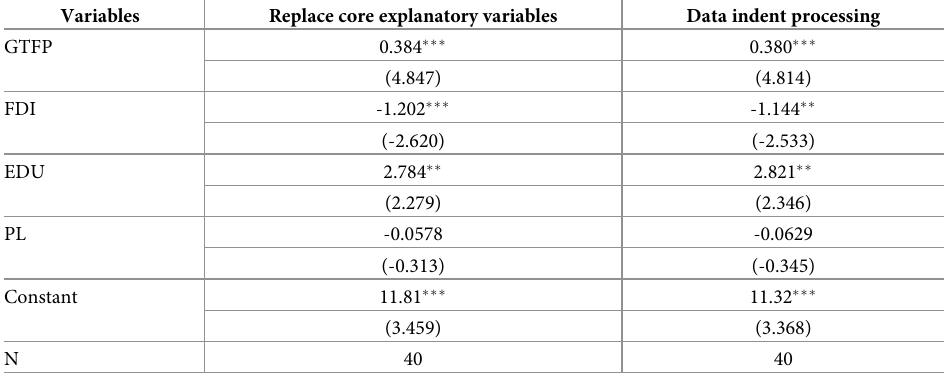
Table 9. Results of the robustness